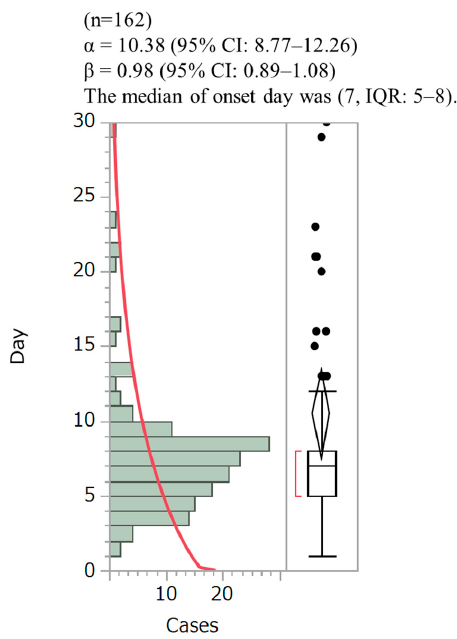
Figure 1. The number of hyponatremia cases associated with cisplatin by onset time in the Japanese Adverse Drug Event Report (JADER) database. Adverse Drug Event Report (JADER)